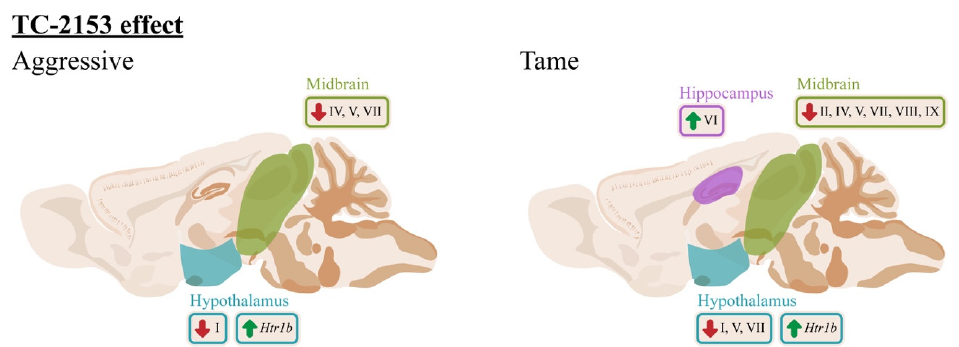
Figure 10. The effects of acute TC-2153 administration on mRNA levels of Bdnf (brain-derived neurotrophic factor) untranslated exons I–VIII and protein-coding exon IX and Htr1a , Htr7 , Htr1b , and Htr2a in the frontal cortex, hippocampus, hypothalamus, and midbrain of aggressive and tame rats. Green arrows indicate an upregulation and red arrows indicate a downregulation of expression after acute administration of TC ‐ 2153.